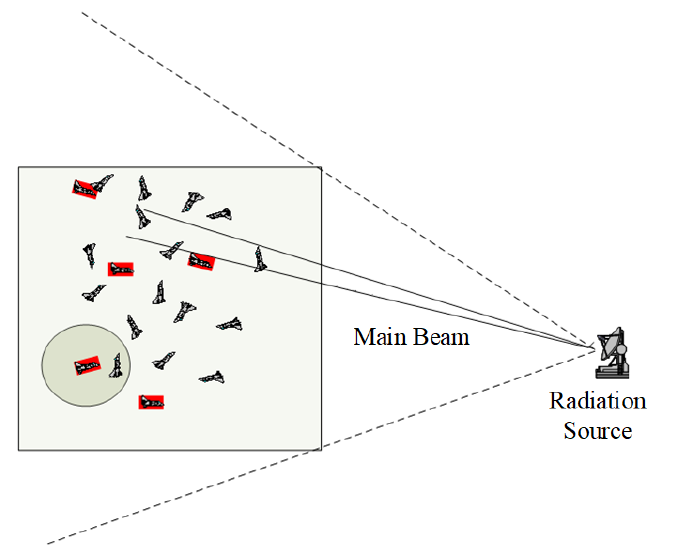
Figure 2. Initial distribution of UAV swarm passive